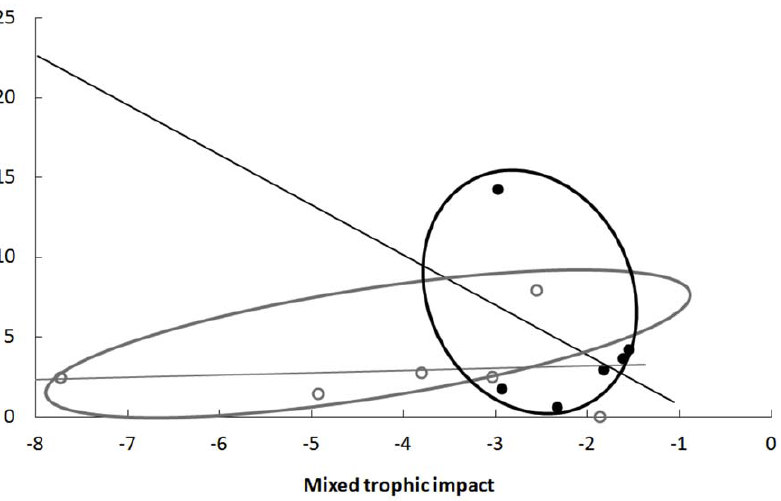
Figure 6. Total consumption by marine mammals (black dots) or total catch by fisheries (open dots) versus their respective overall mixed trophic impact for each studied ecosystem. Density ellipses represent the 90% confidence